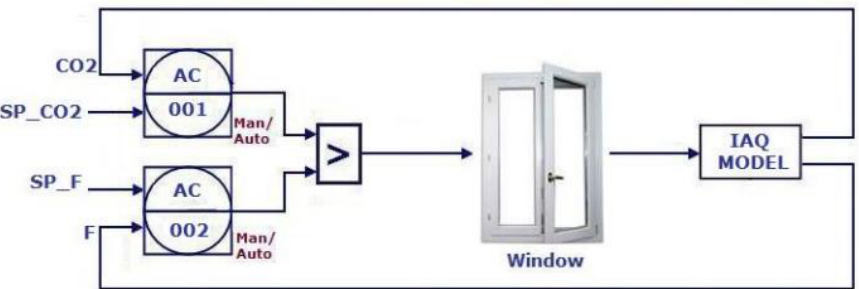
Figure 11. Architecture of the modified control system (IAQ control).